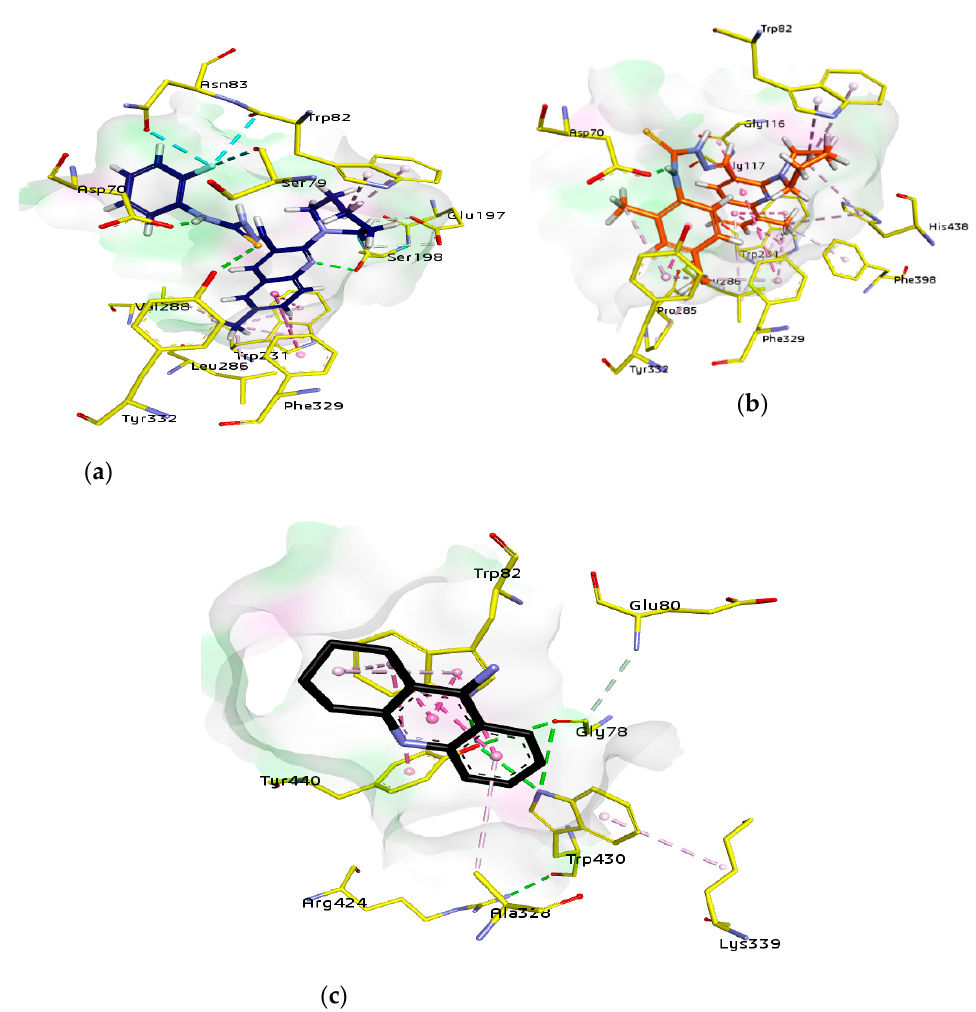
Figure 7. 3D binding modes of 5h ( a ), 6c ( b ), and tacrine ( c ) with the amino acid residue of BChE, hydrogen bonding is shown by green dashed line, hydrophobic interactions are shown by light purple color, dark pink dashed lines show π -T shaped, light pink color shows π - π stacked interactions, and purple color dashed lines show π -sigma type